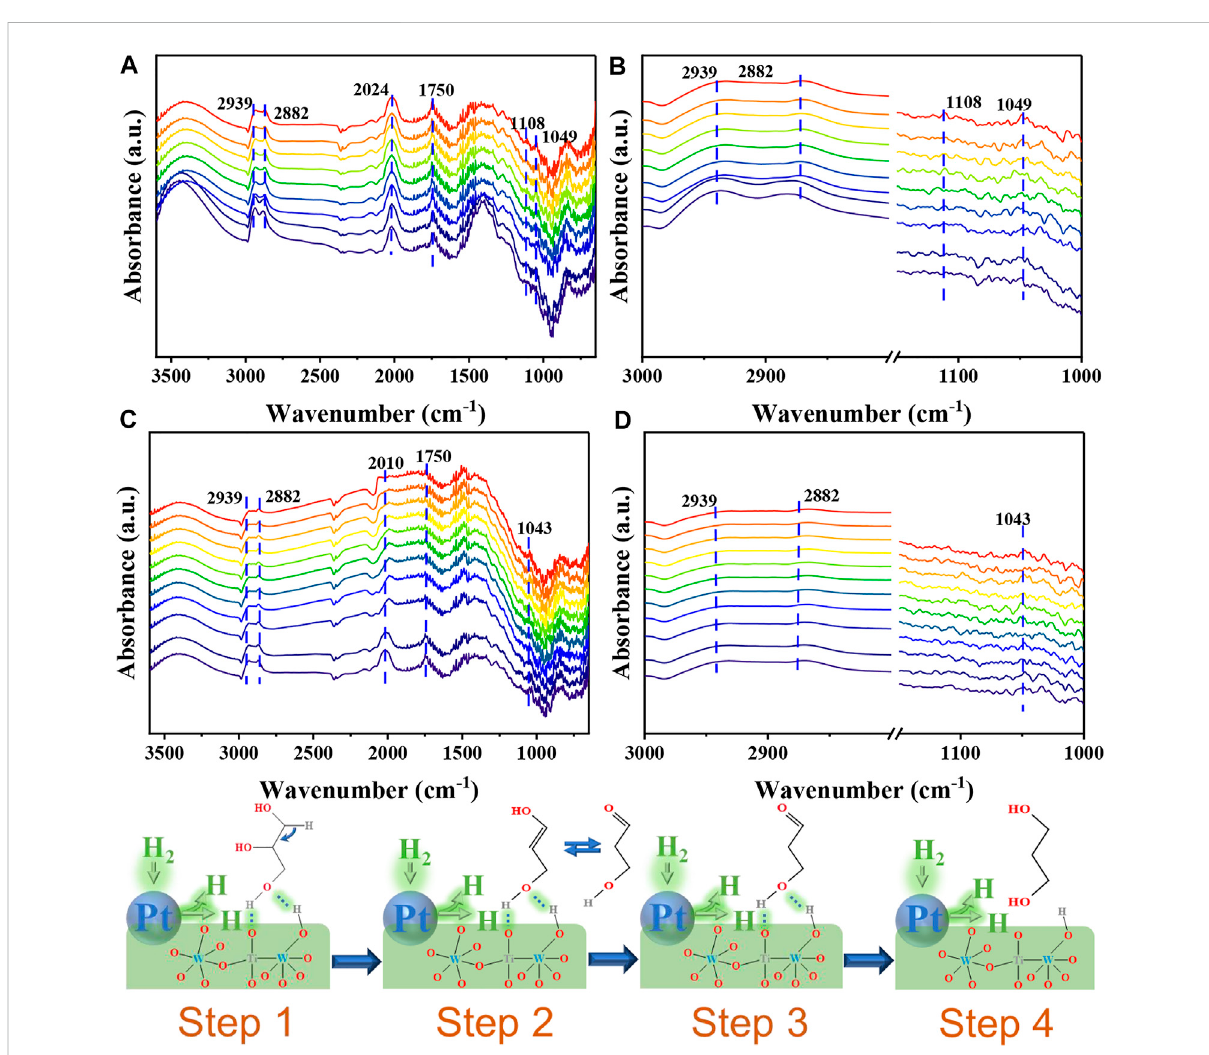
FIGURE 4 In-situ DRIFT pro fi les recorded for the adsorption of glycerol on Pt/5W/A-Ti studied within theinvestigatedregion (A) , and the adsorption state in the (C – H), 3,000 – 2,700 cm − 1 , and (C – O), 1,150 – 950 cm − 1 , regions (B) . Reactive state of glycerol on Pt/5W/A-Ti studied within the investigated region (C) and reactive state in the (C – H), 3,000 – 2,700 cm − 1 , and (C – O), 1,150 – 950 cm − 1 , regions (D) . Schematic diagram of the reaction mechanism (Step 1 –